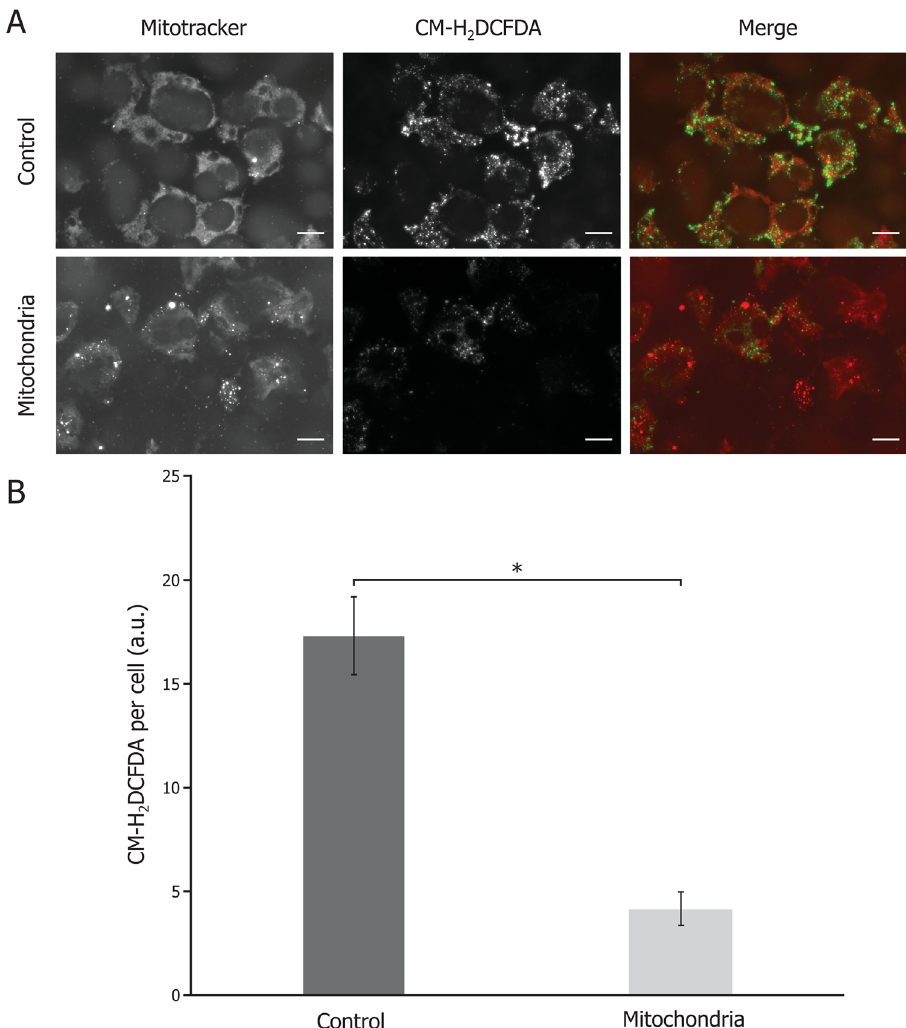
Figure 3. Oxidative stress is reduced in FECD cells when exposed to exogenous mitochondria. ( A ) A marker of oxidative stress (CM-H2DCFDA; green) was used in conjunction with a mitochondrial mass marker (mitotracker; red) in FECD explants exposed to exogenous mitochondria or not (Control). ( B ) CM-H2DCFDA signal per cell is significantly reduced in FECD explants that received exogenous mitochondria, compared to control explants. Scale bar = 40 µm. Experiments were performed on 4 explants from 4 FECD patients (Total 41 microscope fields analyzed). *p <